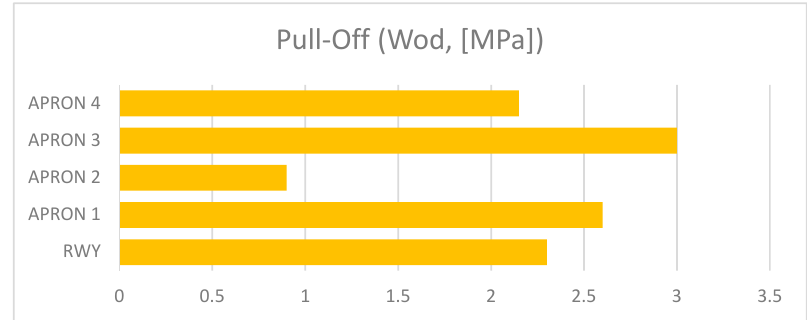
Figure 10. Bond strength by pull-off of AFE’s.